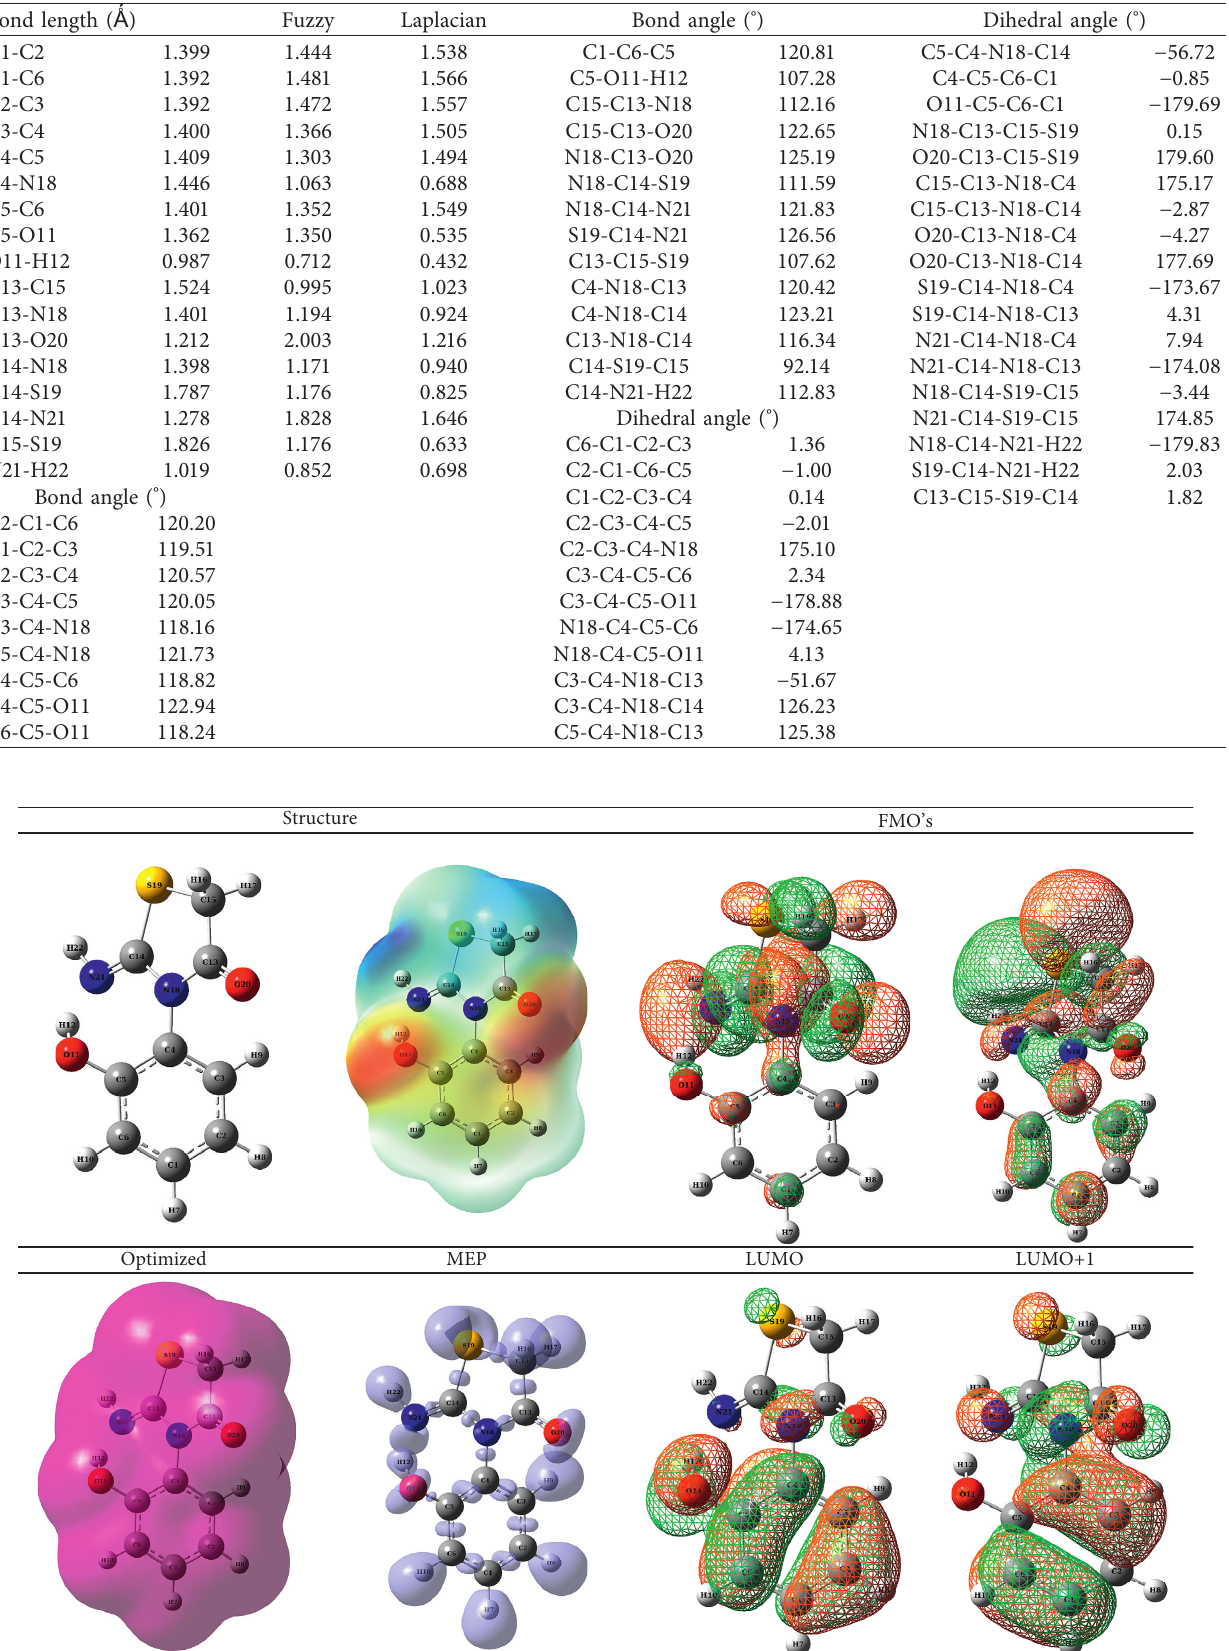
Table 2: Optimized geometrical parameters and bond order of L1.